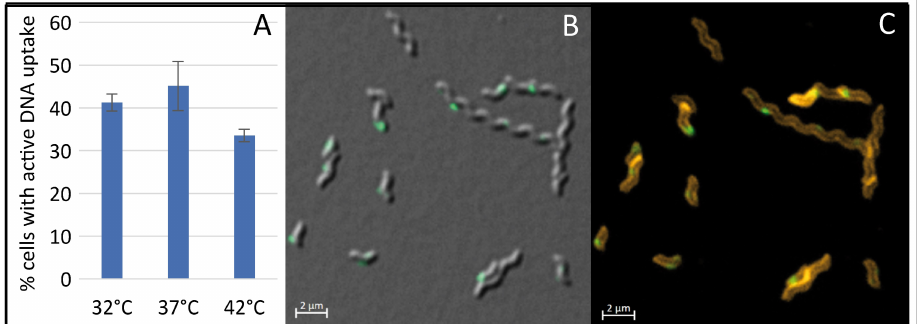
Figure 5. Growth temperature only marginally influences competence development in C. jejuni . Fraction of competent C. jejuni grown to exponential phase at pH 7.5 at 32 ◦ C, 37 ◦ C and 42 ◦ C ( A ). Bacterial morphology and DNA uptake locations of bacteria grown at 32 ◦ C were displayed by an overlay differential phase contrast (DIC) image with the Fluorescein channel (labelled DNA, in green) ( B ) or by an overlay image of the Fluorescein channel (labelled DNA) and the Cyanine-3 (Cy3) channel (membranes stained with the commercial dye, SynaptoRed C2) ( C ). Scale bar, 2 µ m. DNA uptake was performed at 37 ◦ C under aerobic conditions. Experiments were performed at least three times. Error bars indicate standard